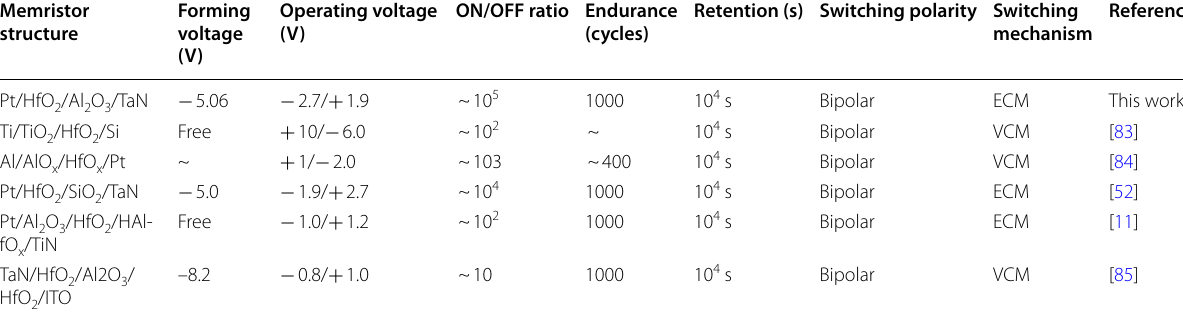
-based bilayer and trilayer memristor 2